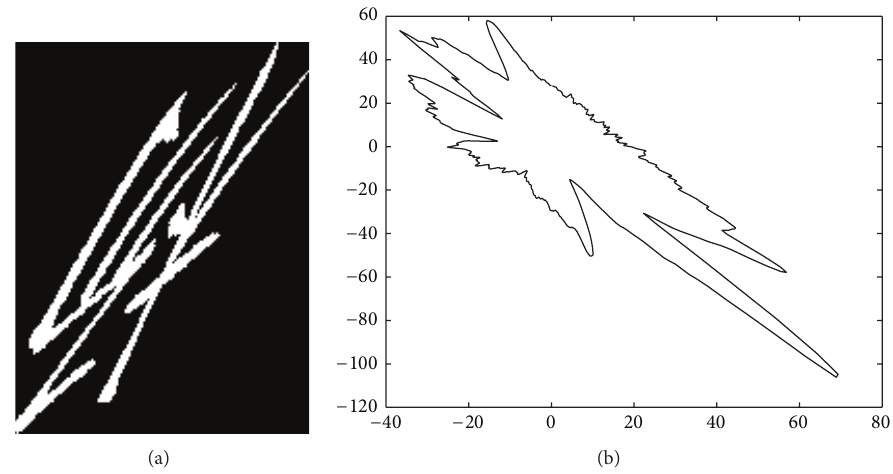
Figure 3: (a) An affine transformation version of Figure 2(a). (b) GC derived from (a).